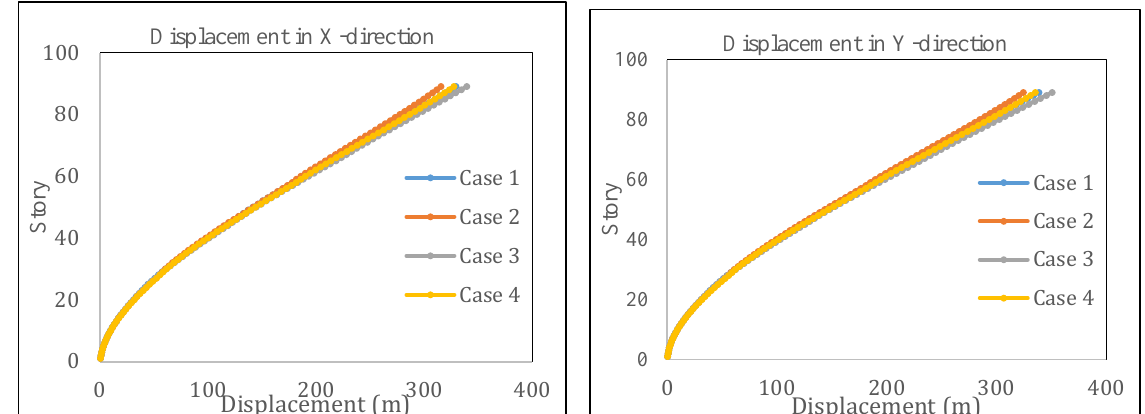
Fig. 7. Story-Displacement curves in X and Y directions for